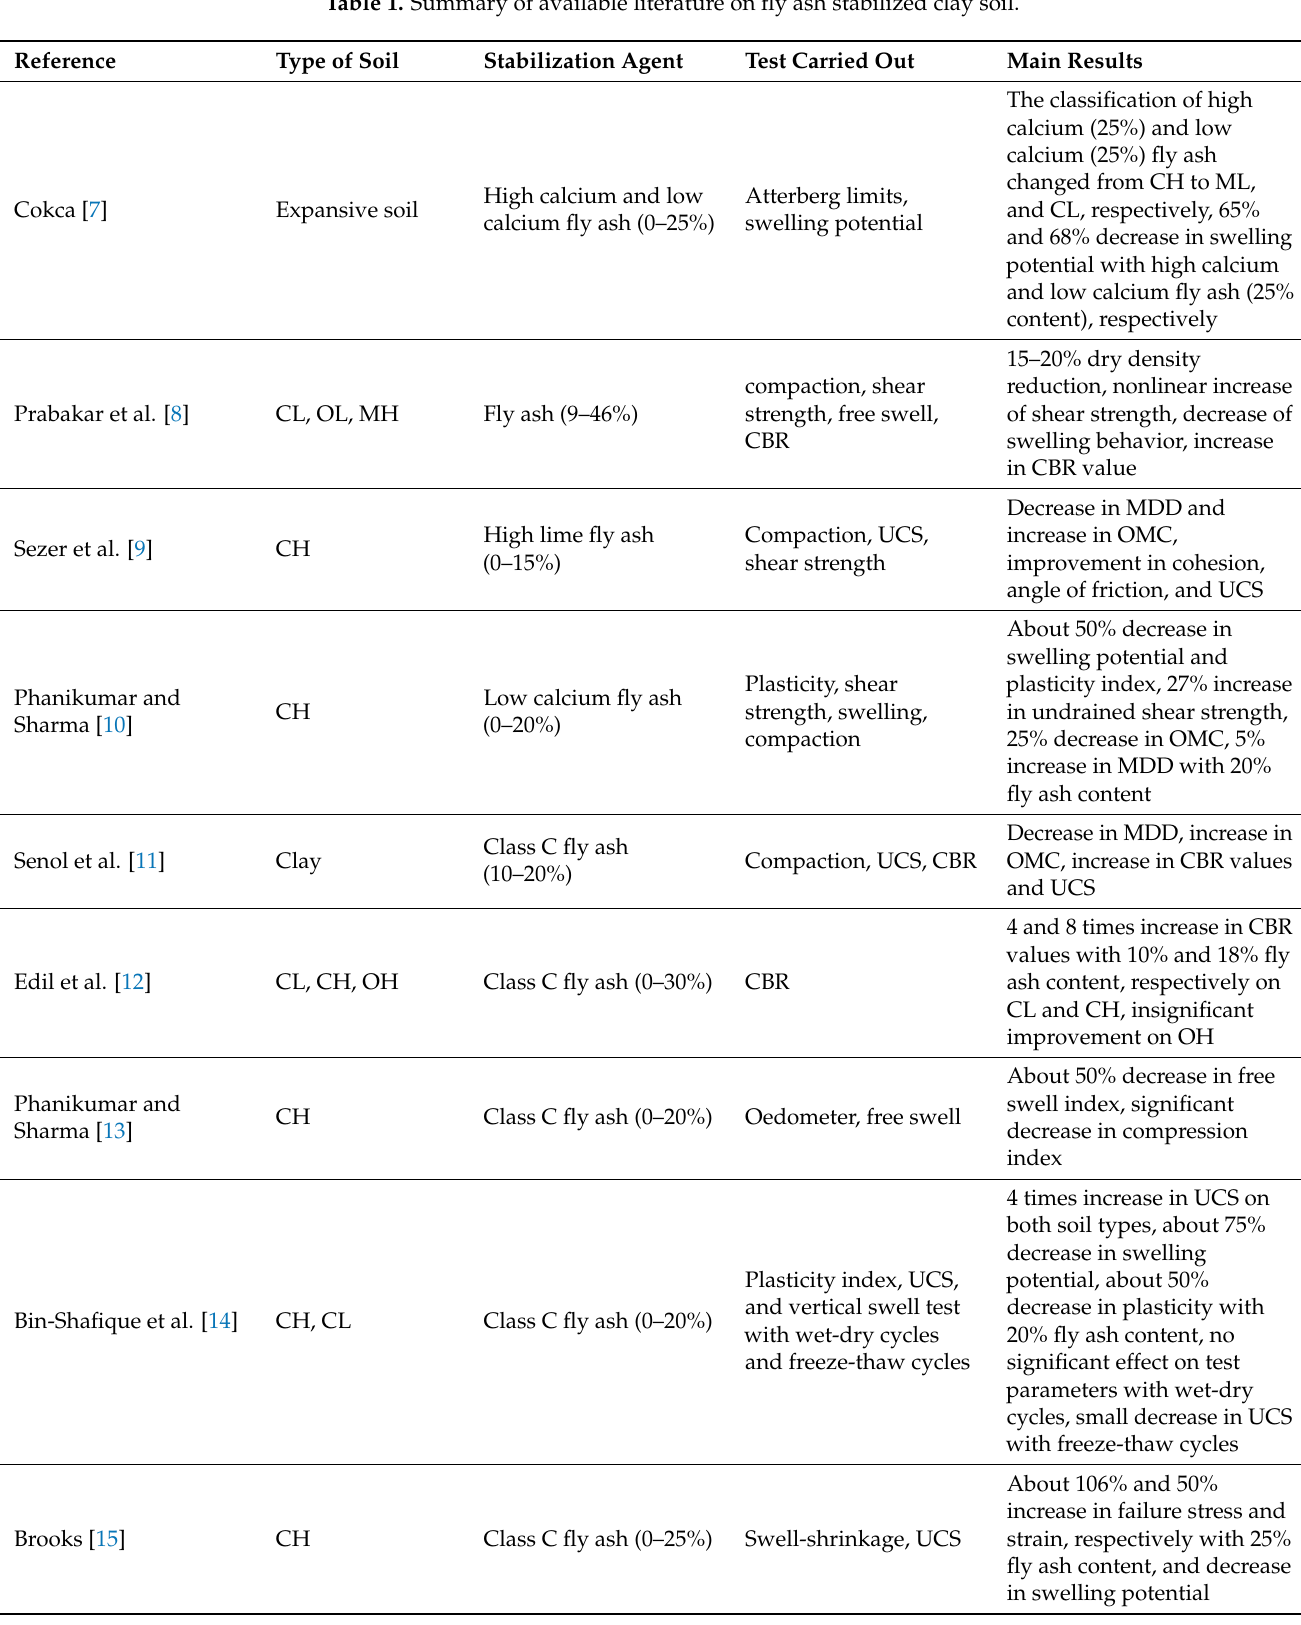
Table 1. Summary of available literature on fly ash stabilized clay